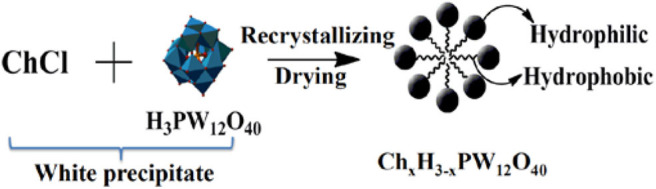
The synthetic procedure of ChxH3−xPW12O40 catalyst.